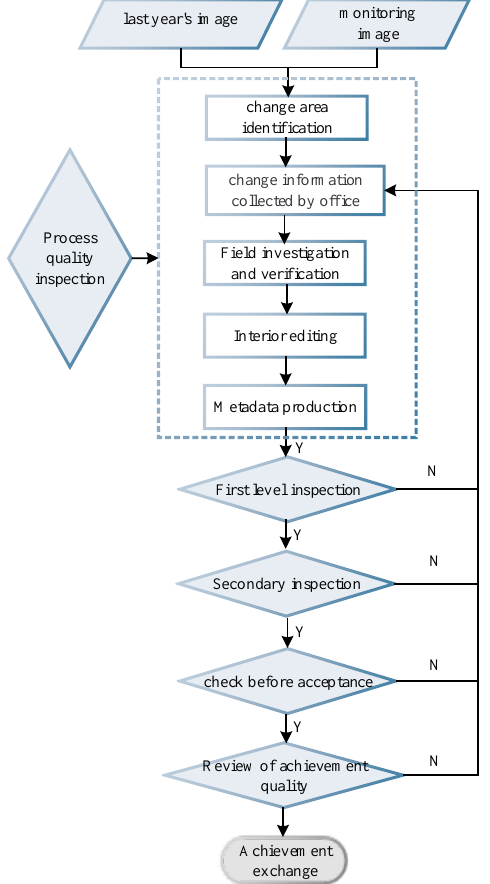
Figure 1. Production and Quality Control Process of Land Cover Classification